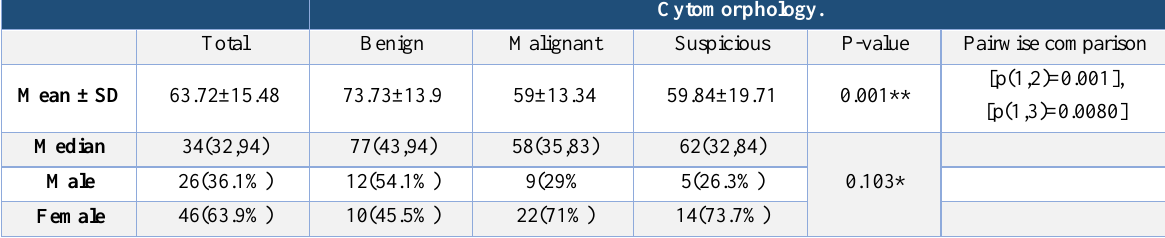
Table 1 . Age and sex distribution of patients (Mean ± SD).